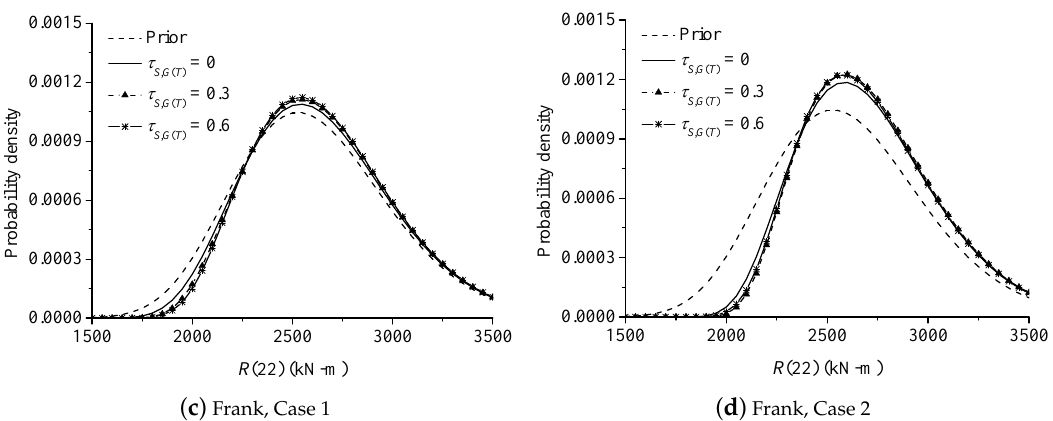
Figure 4. Updated and prior PDFs of R ( 22 ) with different values of τ S , G ( T )